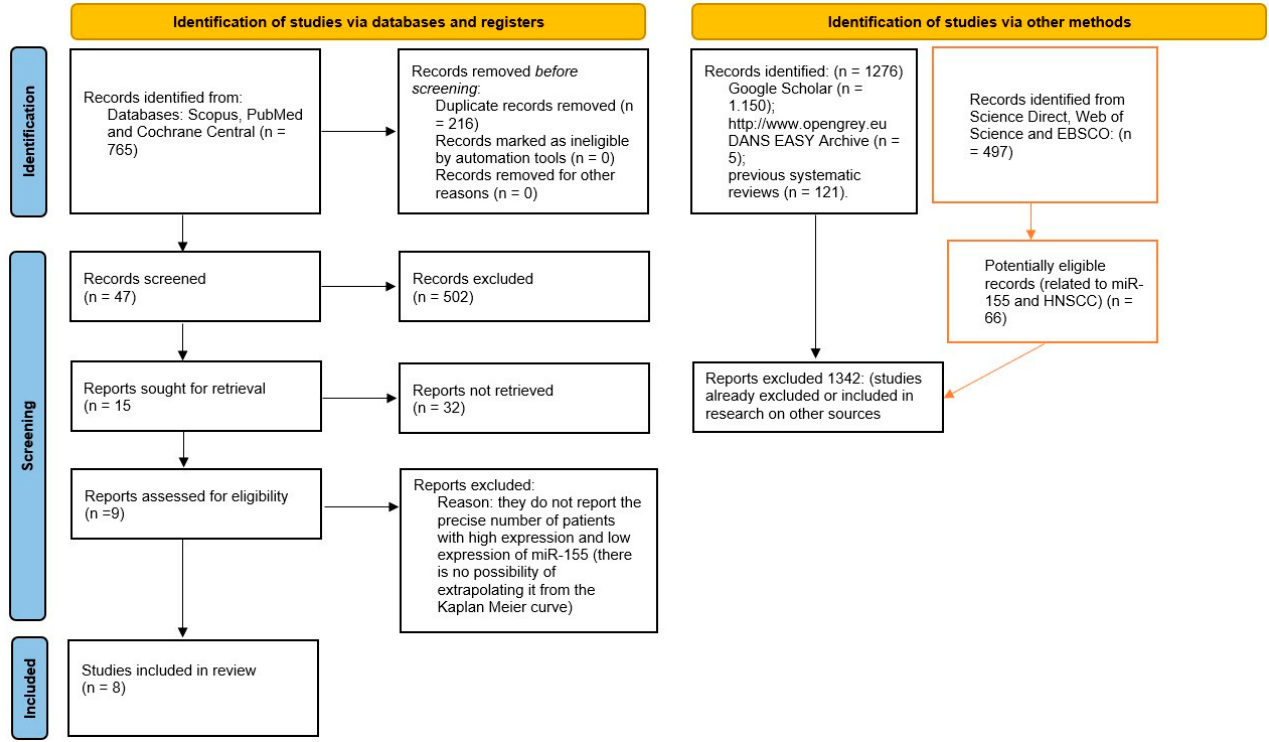
Figure 1. The entire selection and screening procedures are described in the PRISMA; tables with the red lines are the searches performed subsequently (on 12 April 2022), with the addition of Web of Science, Science Direct, and EBSCO .